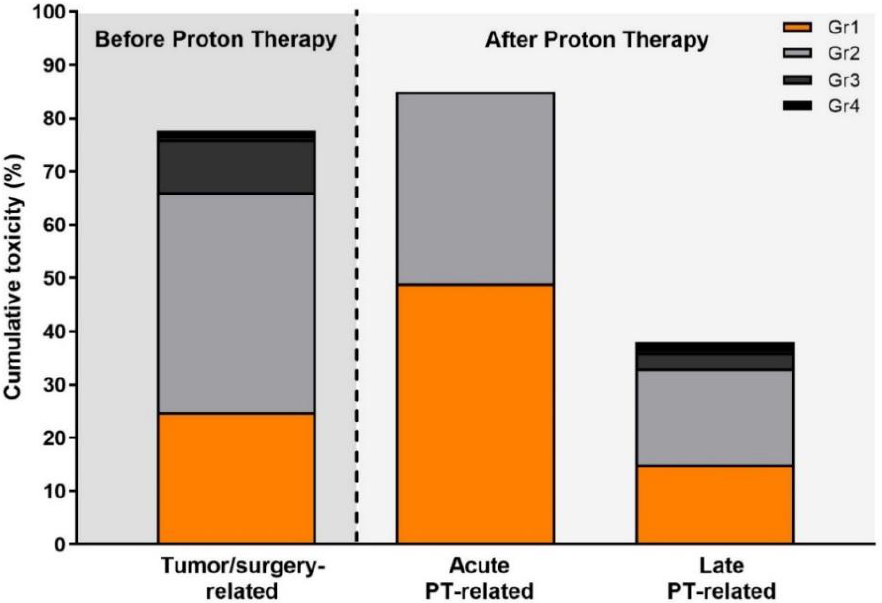
Figure 3. Percentage of the number of patients with observed tumor/surgery-related toxicity directly before proton therapy (PT), PT-related acute ( ≤ 3 months) and late ( ≥ 3 months) toxicity, graded by use of Common Terminology Criteria for Adverse Events (CTCAE) v4.03.